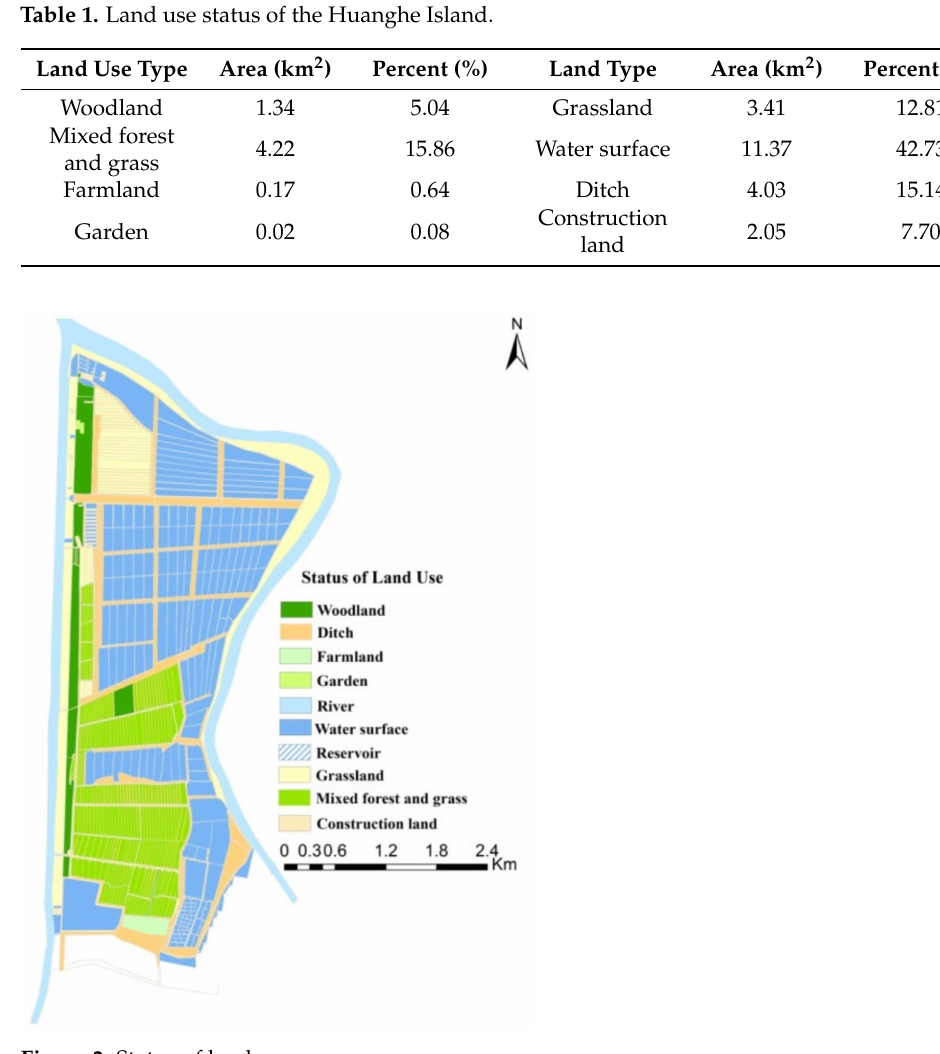
Figure 2. Status of land